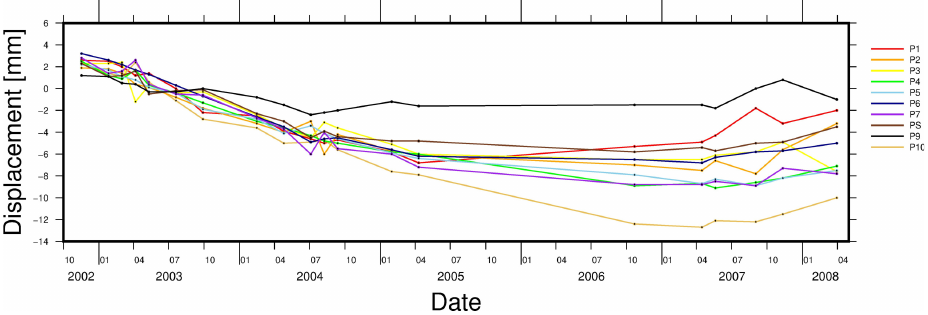
Figure 10. LOS displacements in the 2002–2008 period—Envisat.